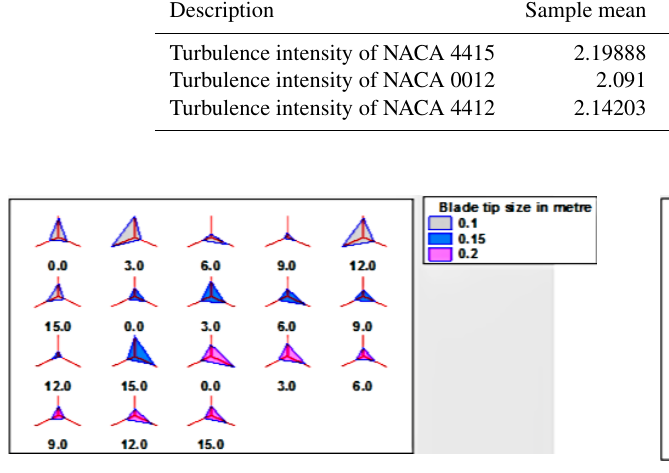
Figure 10. Vorticity values are displayed for NACA airfoils for three different blade tip sizes and six different blade twist angles.